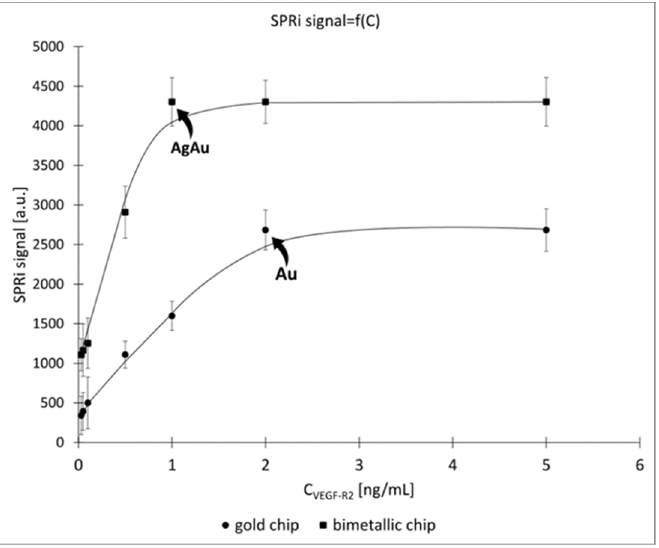
Figure A1. Calibration curve over the full concentration range. Ligand concentration was 20 ng/mL, pH = 7.40.